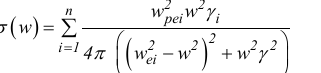
Figure 4. (a) the real part of the dielectric constant spectra and (b) the optical conductivity spectra for InSe and InSe/Sb The dielectric constants ratio ( R ) and the optical conductivities ratio ( R σ ) is also displayed in (a) and (b), ε